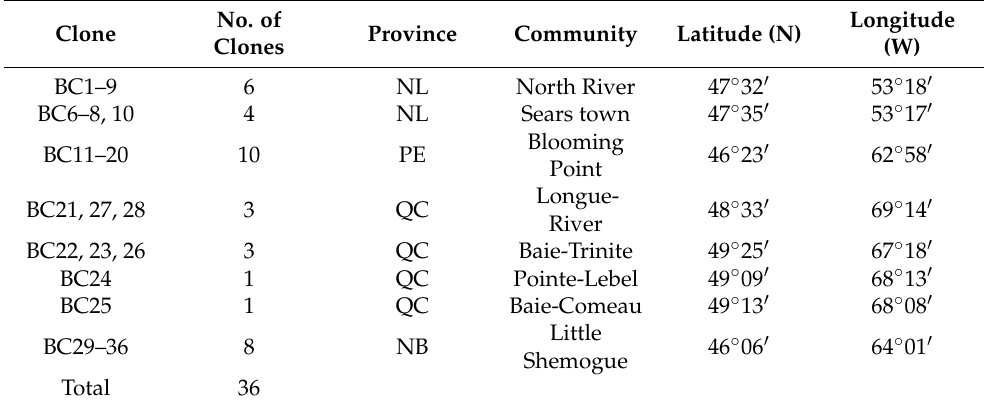
Table 2. Wild blueberry clones, designated as BC1 to BC36, collected from the Canadian provinces of Newfoundland and Labrador (NL), Prince Edward Island (PE), Quebec (QC), and New Brunswick